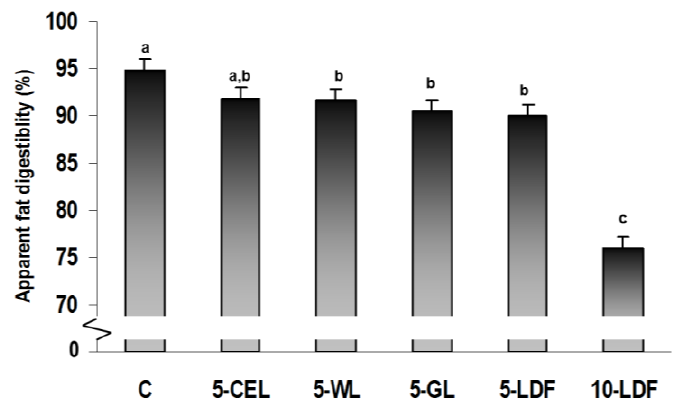
Figure 1. Apparent fat digestibility (% of intake) during the last 5 days of a 21 days feeding trial in rats fed six different diets (C = control; 5-CEL = 5% dietary fibers (DF) from cellulose; 5-WL = 5% DF from whole linseed; 5-GL = 5% DF from ground linseeds; 5-LDF = 5% DF from linseed DF extract; 10-LDF = 10% F from linseed DF extract) (Mean ± SE) ( n = 10). Mean values with different letters were significantly different ( p < 0.05; ANCOVA, followed by least significant difference